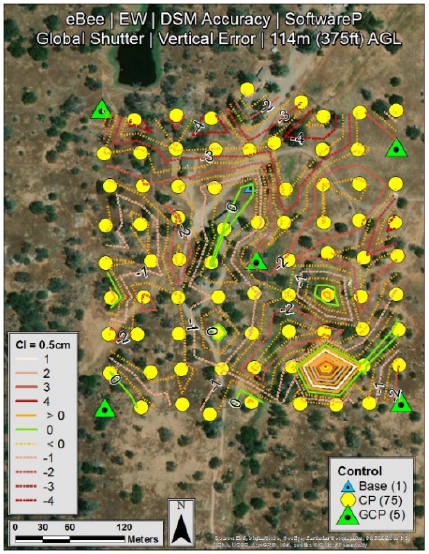
Figure 3. UAV-derived DSM (2.5 cm/pix) vertical error contour map using Pix4D with 5 GCP